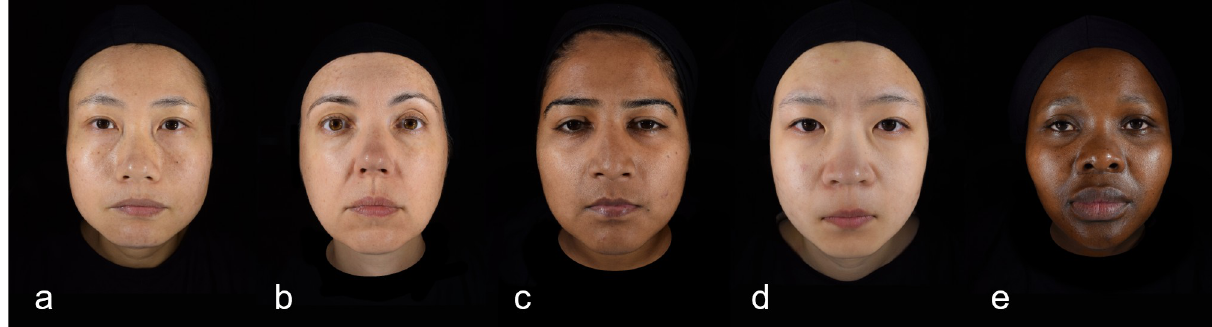
Fig 1. Samples images of female participants for presentation in the rating study. Chinese a), French b), Indian c), Japanese d), and S. African e).